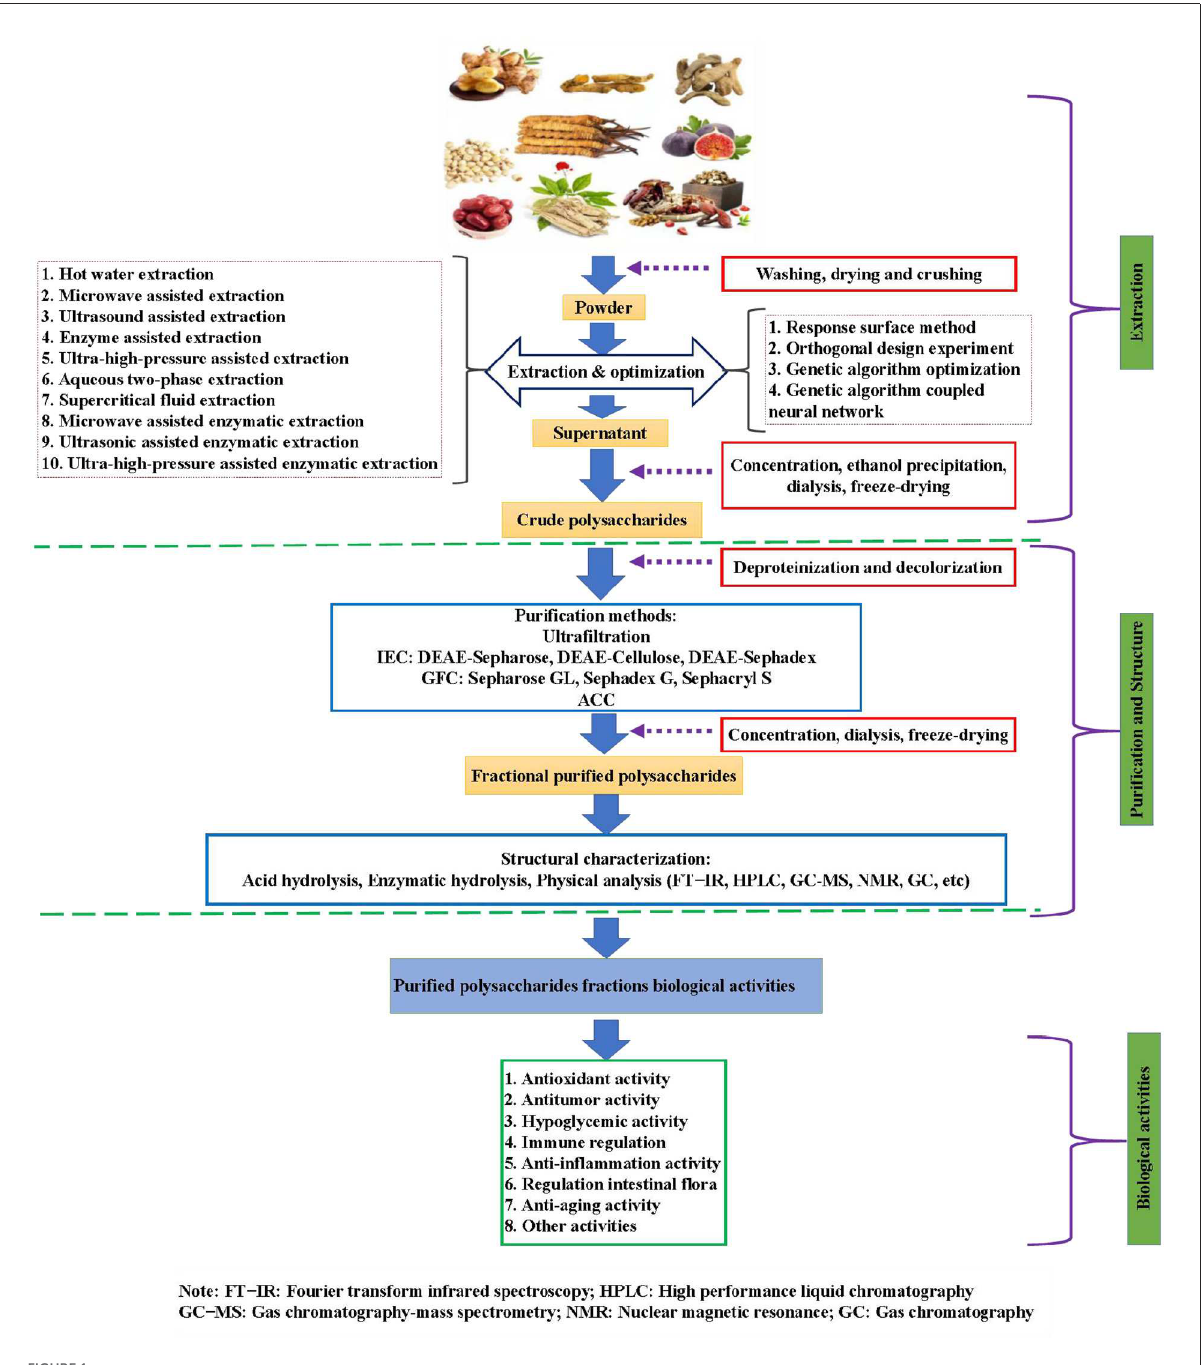
FIGURE1 The schematic diagram of extraction and purification methods, structural characterization, chemical modification, and biological activities of TCMPs.